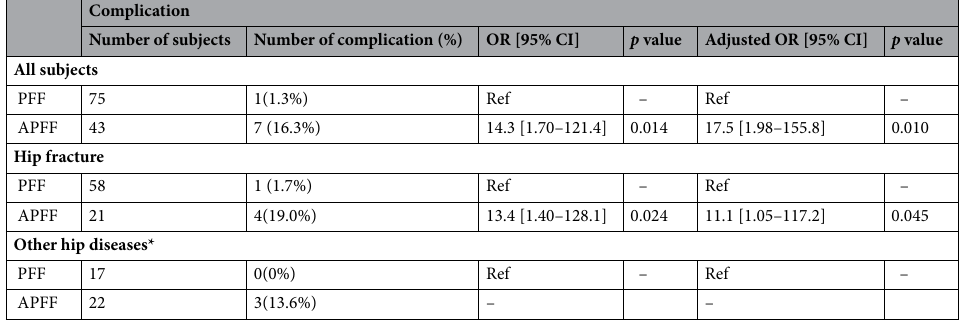
Table 3. Multivariable logistic regression analyses. *Osteoarthritis, rheumatoid arthritis, osteonecrosis.